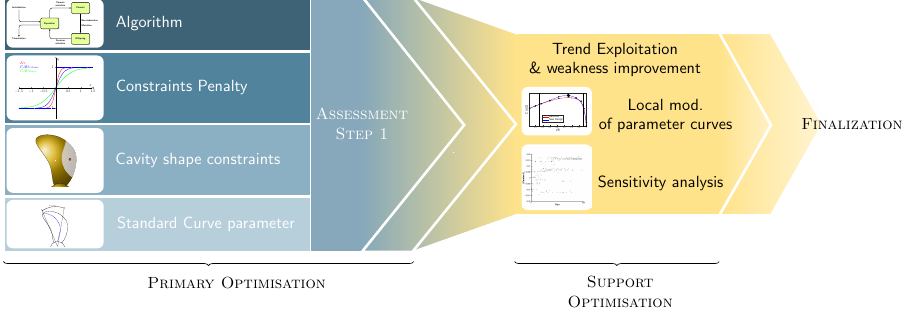
Figure 2. Two-stage propeller